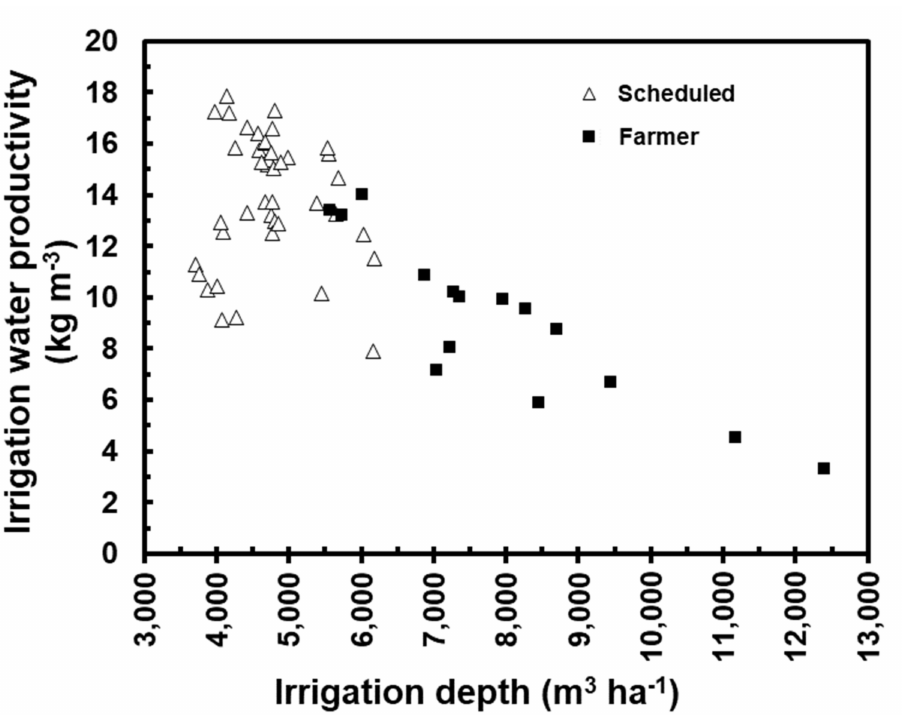
Figure 5. Irrigation water productivity as a function of the irrigation depth applied according to the irrigation scheduled by IFAPA and the farmer irrigation in 38 strawberry plots.